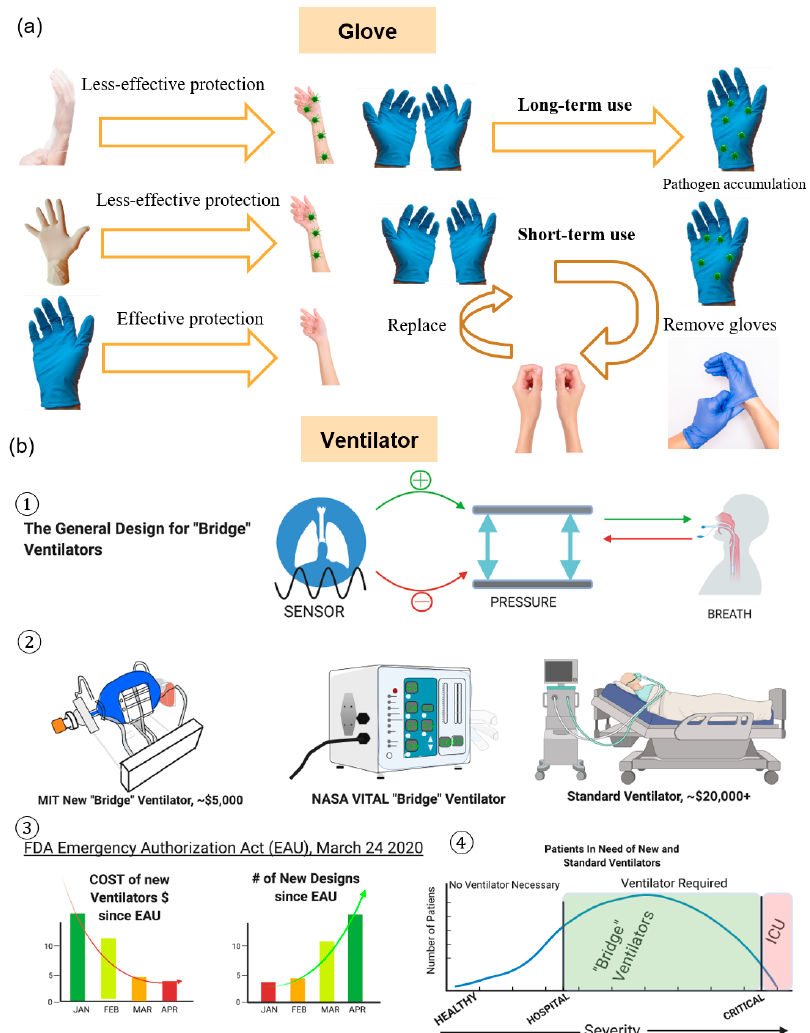
Figure 4. COVID-19 control by gloves and ventilators. ( a ) Gloves must be changed regularly and properly disposed of in biosafe disposal units. Not all gloves block the penetration of the virus. Thicker gloves offer a thicker barrier and better defense against COVID-19 droplets; ( b ) (1) The general design for new ventilators includes a breath sensor that senses the timing and size of breaths, a pressure pump that pumps air into and out of the lungs, and a tracheal tube that pumps air directly into the lungs; (2) Depiction of the Massachusetts Institute of Technology (MIT) New “Bridge” ventilator which uses a mechanical pump and a bag-valve-mask to administer air (left). The National Aeronautics and Space Administration (NASA) VITAL uses sensors and a mechanical pump to deliver safe breaths. Their design is licensable to accepted manufacturers (middle). A standard intensive care unit (ICU) ventilator is fully equipped with vitals monitoring, air delivery, and a computer that measures vitals and pressure for safe breathing. The safest option for patients in critical condition but are more expensive to produce are presented (right); (3) The Food and Drug Administration (FDA)’s Emergency Use Authorization (EUA) for mechanical ventilators helped drastically reduce the cost of new devices and increased the number of new device designs; (4) Newly developed ventilators are termed “bridge” ventilators and are intended for an intermediate use between hospitalized patients and critically ill patients. “Bridge” ventilators are used when standard ICU ventilators are not available, and standard ICU ventilators are still the safest option for patients in critical